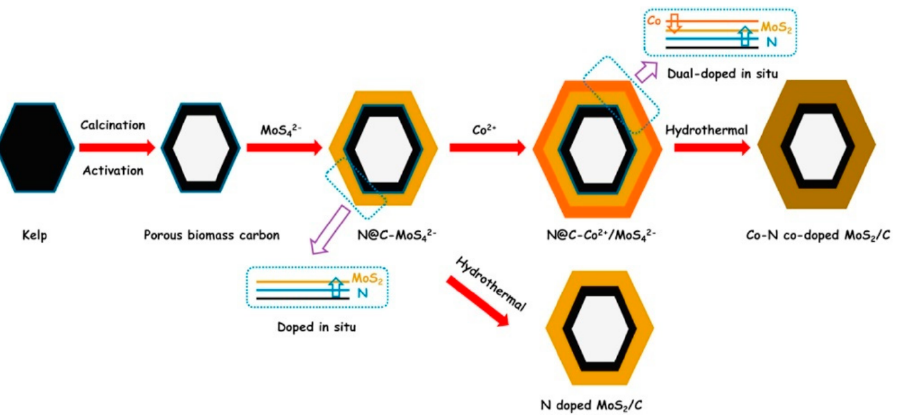
Figure 25. Schematic illustrations of the preparation processes of the Co/N dual-doped-MoS2/C heterostructure composite. Reproduced from [139] with the permission of